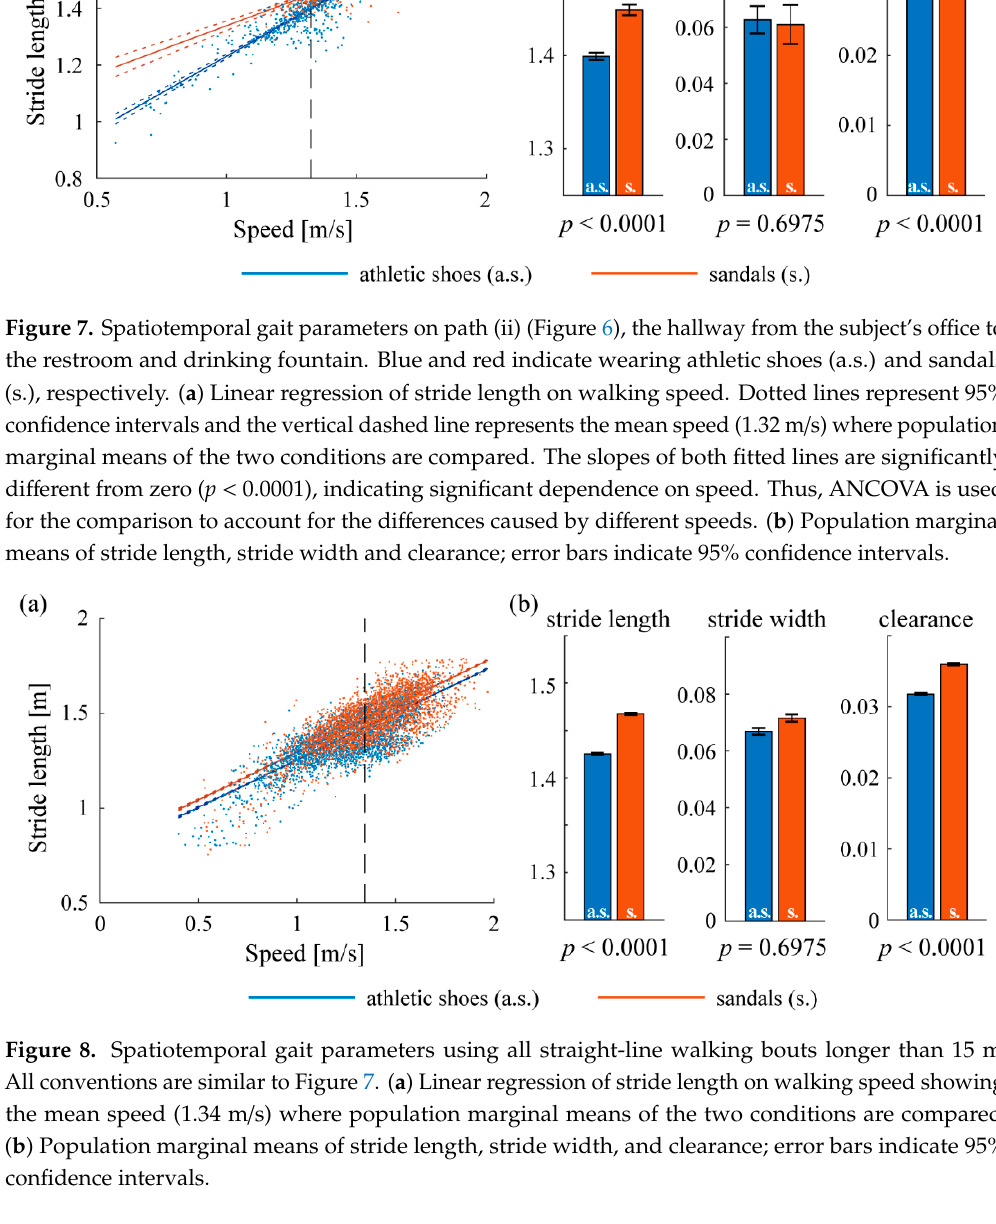
Figure 8 . Spatiotemporal gait parameters using all straight-line walking bouts longer than 15 m. All conventions are similar to Figure 7. ( a ) Linear regression of stride length on walking speed showing the mean speed (1.34 m/s) where population marginal means of the two conditions are compared. ( b ) Population marginal means of stride length, stride width, and clearance; error bars indicate 95% confidence intervals.